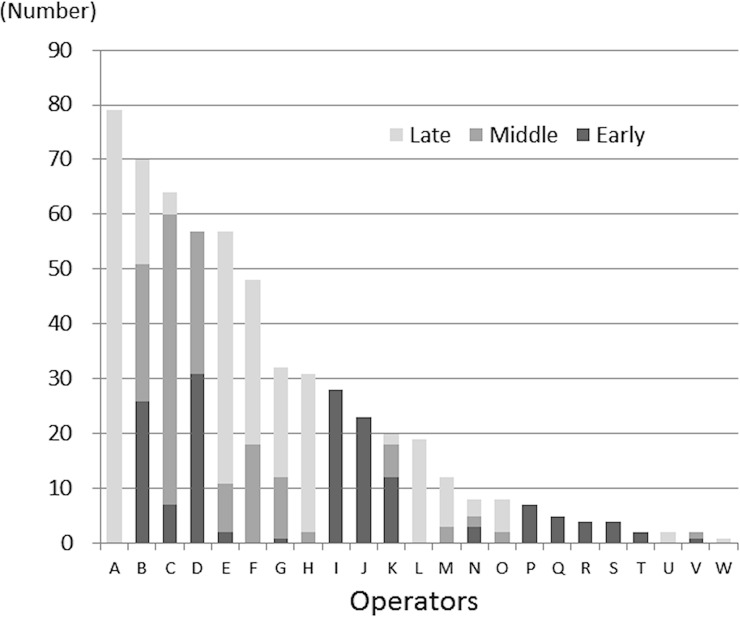
The numbers of colorectal ESD of each operator.Early, early period (2005–2010); Middle, middle period (2011–2013); Late, late period (2014–2015).